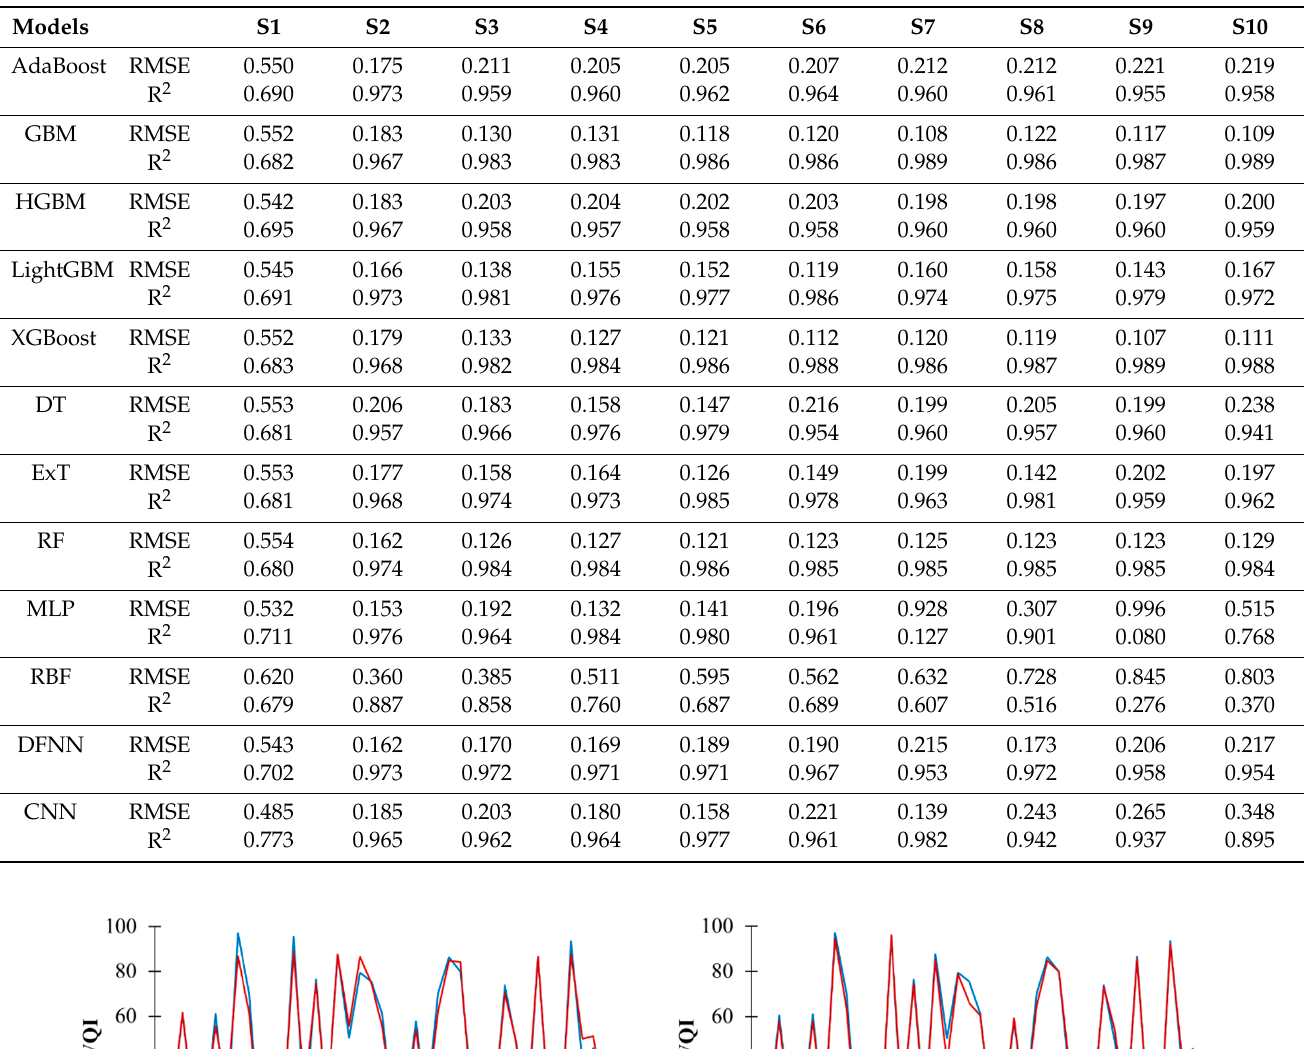
Table 4. Efficiency statistics of the 12 ML model under the 10 scenarios of input variable combinations during the testing process.